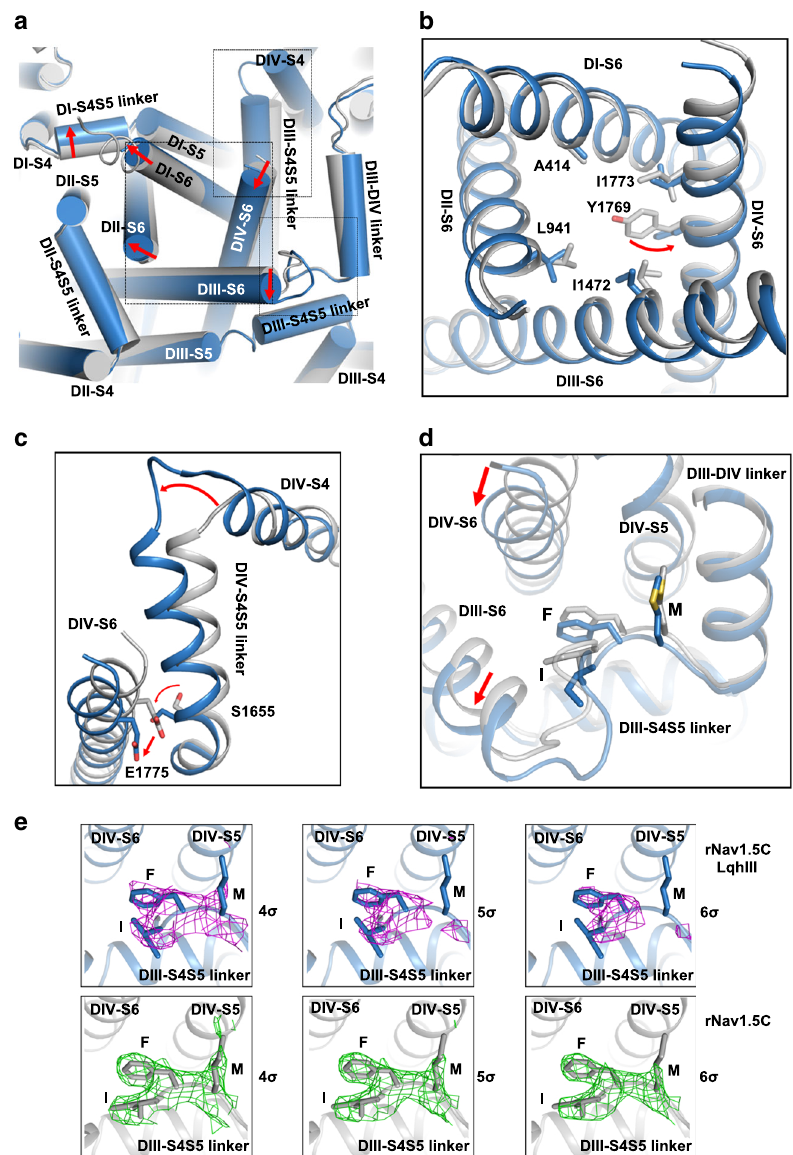
Fig. 5 Coupling of LqhIII binding and conformational change in D IV-VS to the S4 – S5 linkers and the intracellular activation gate. a Superposition of Na V 1.5 intracellular gate between activated (grey) and intermediate-activated (blue) states of the D IV-VS. Red arrows indicate the conformational changes. The black dash squares indicated for panels ( b – d ). b Zoom-in view of the intracellular activation gate with constriction residues shown in sticks. c Zoom-in view of D IV S4 – S5 linker mediates the conformational changes. d Zoom-in view of IFM motif shift between activated and deactivated state. e Close-up views of the IFM motif in the free and LqhIII-complexed Na V 1.5 together with its cryo-EM density contoured at different σ